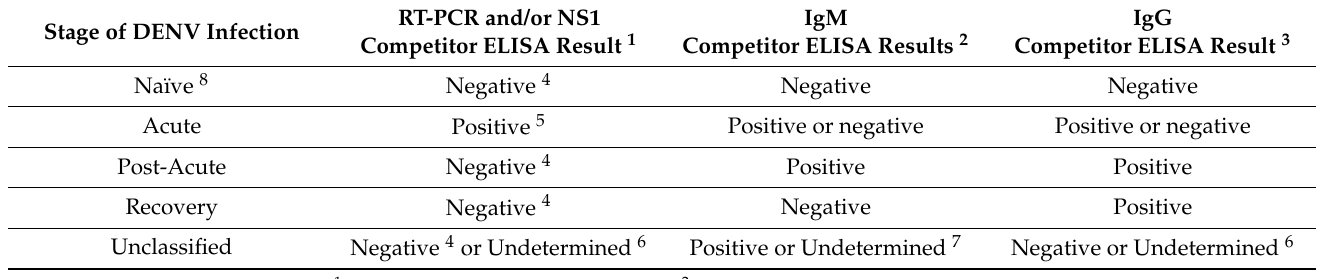
Table 3. Definition of DENV infection stages according to the competitor ELISA and RT-PCR test